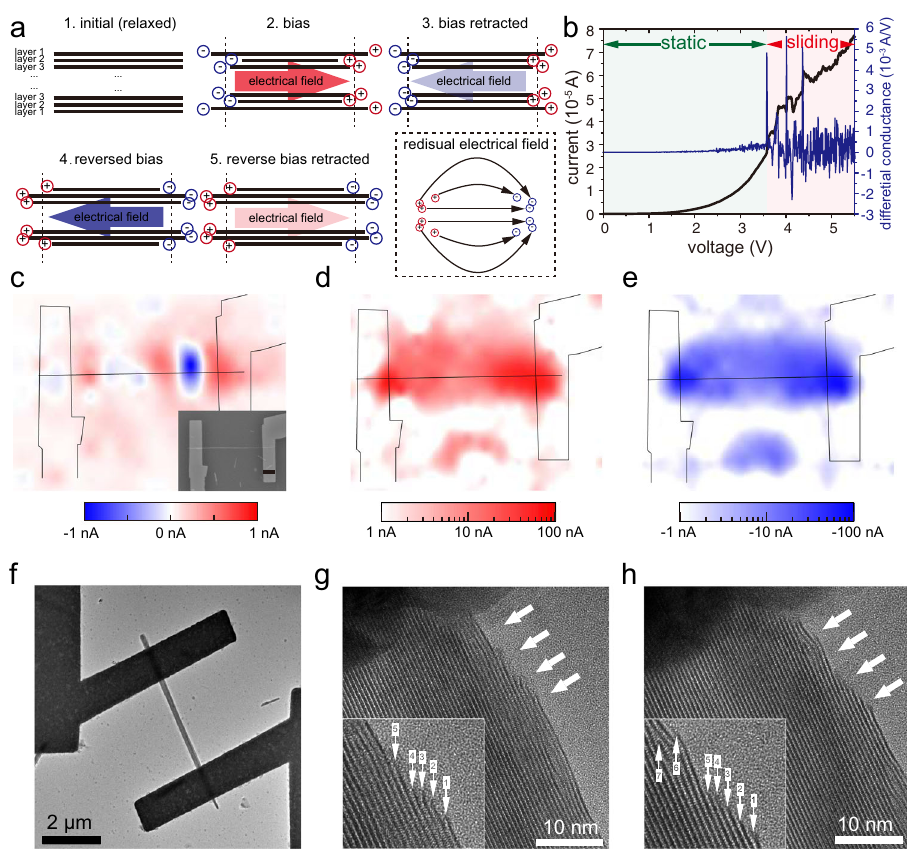
Fig. 4 | Mechanism ofthe programmablephotovoltaic effect. a Sliding between the WS 2 layers, which generates residual strain and a spontaneous electric fi eld. b Current and differential conductance versus voltage bias. c Mapped photo- current of a WS 2 nanotube device before bias. The scale bar is 2 μ m. d , e